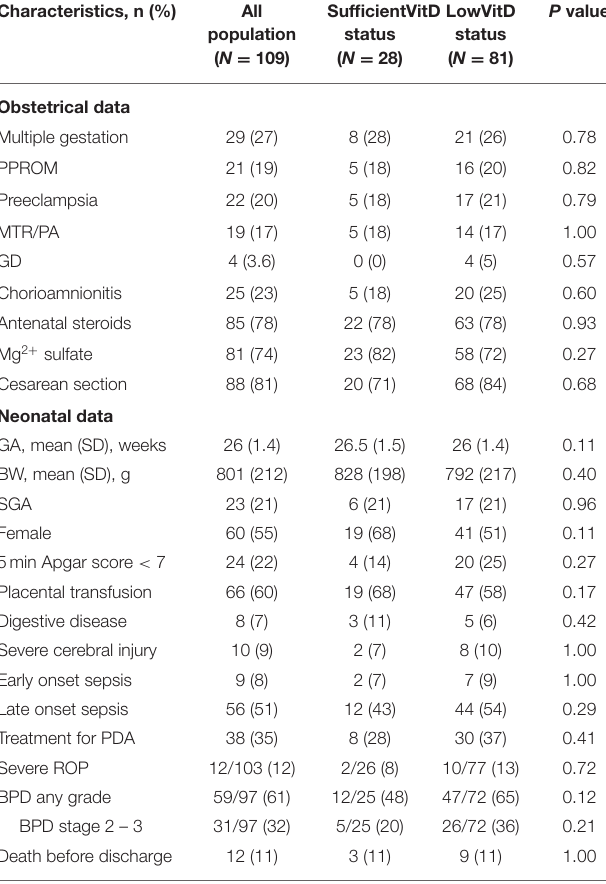
TABLE 2 | Early respiratory outcomes according to vitamin D status at birth. Characteristics, n